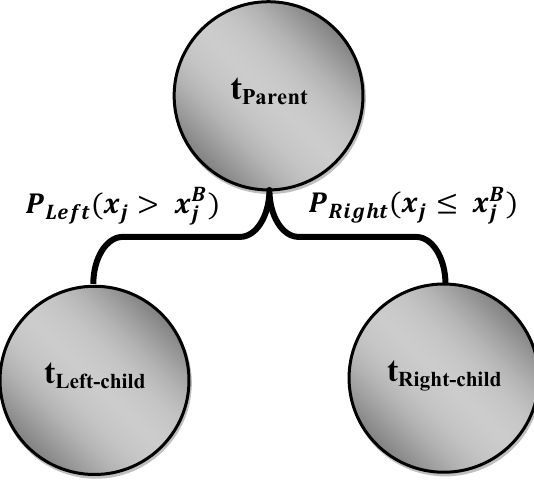
Figure 6. The splitting algorithm of the Classification and Regression Tree (CART), where , (cid:1872) , and (cid:1872) are parent, left, and right nodes, (cid:1876) (cid:1872) (cid:3017)(cid:3028)(cid:3045)(cid:3032)(cid:3041)(cid:3047) (cid:3013)(cid:3032)(cid:3033)(cid:3047)(cid:2879)(cid:3030)(cid:3035)(cid:3036)(cid:3039)(cid:3031) (cid:3019)(cid:3036)(cid:3034)(cid:3035)(cid:3047)(cid:2879)(cid:3030)(cid:3035)(cid:3036)(cid:3039)(cid:3031) variable j , and (cid:1876) (cid:3037)(cid:3003) is the best splitting value of the (cid:1876) (cid:3037)